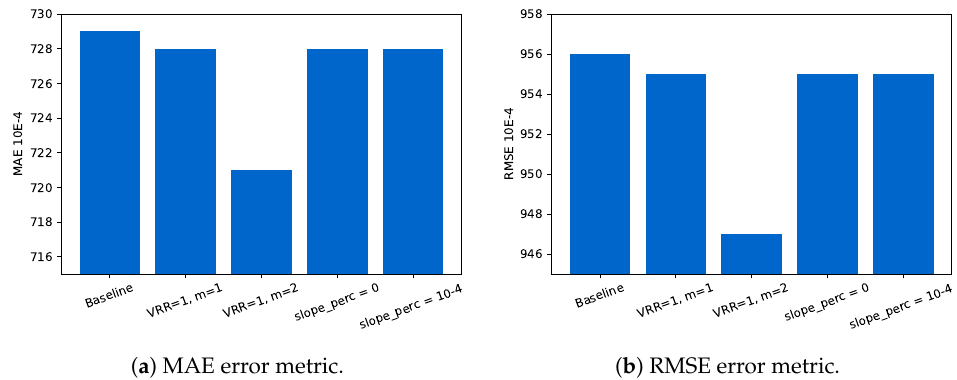
Figure 5. Error values for the representative regression SK